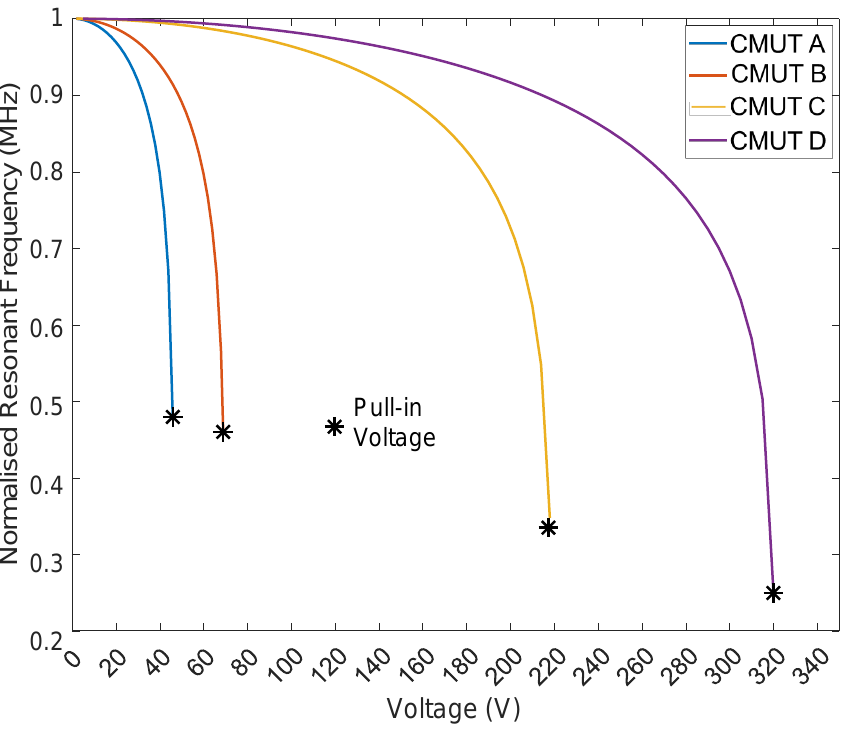
Figure 11. DC voltage vs. normalized resonant frequency for CMUTs.